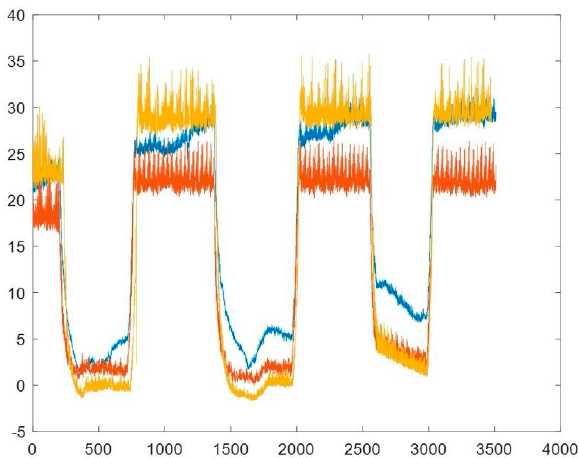
Figure 7. The pressure wave changes in the normal pressure phase to intraabdominal hypertension phase recorded intraluminally from the PressureDot (yellow line), intravesically from the pressure probe (brown line) and intraabdominally from the intraperitoneal pressure probe (blue